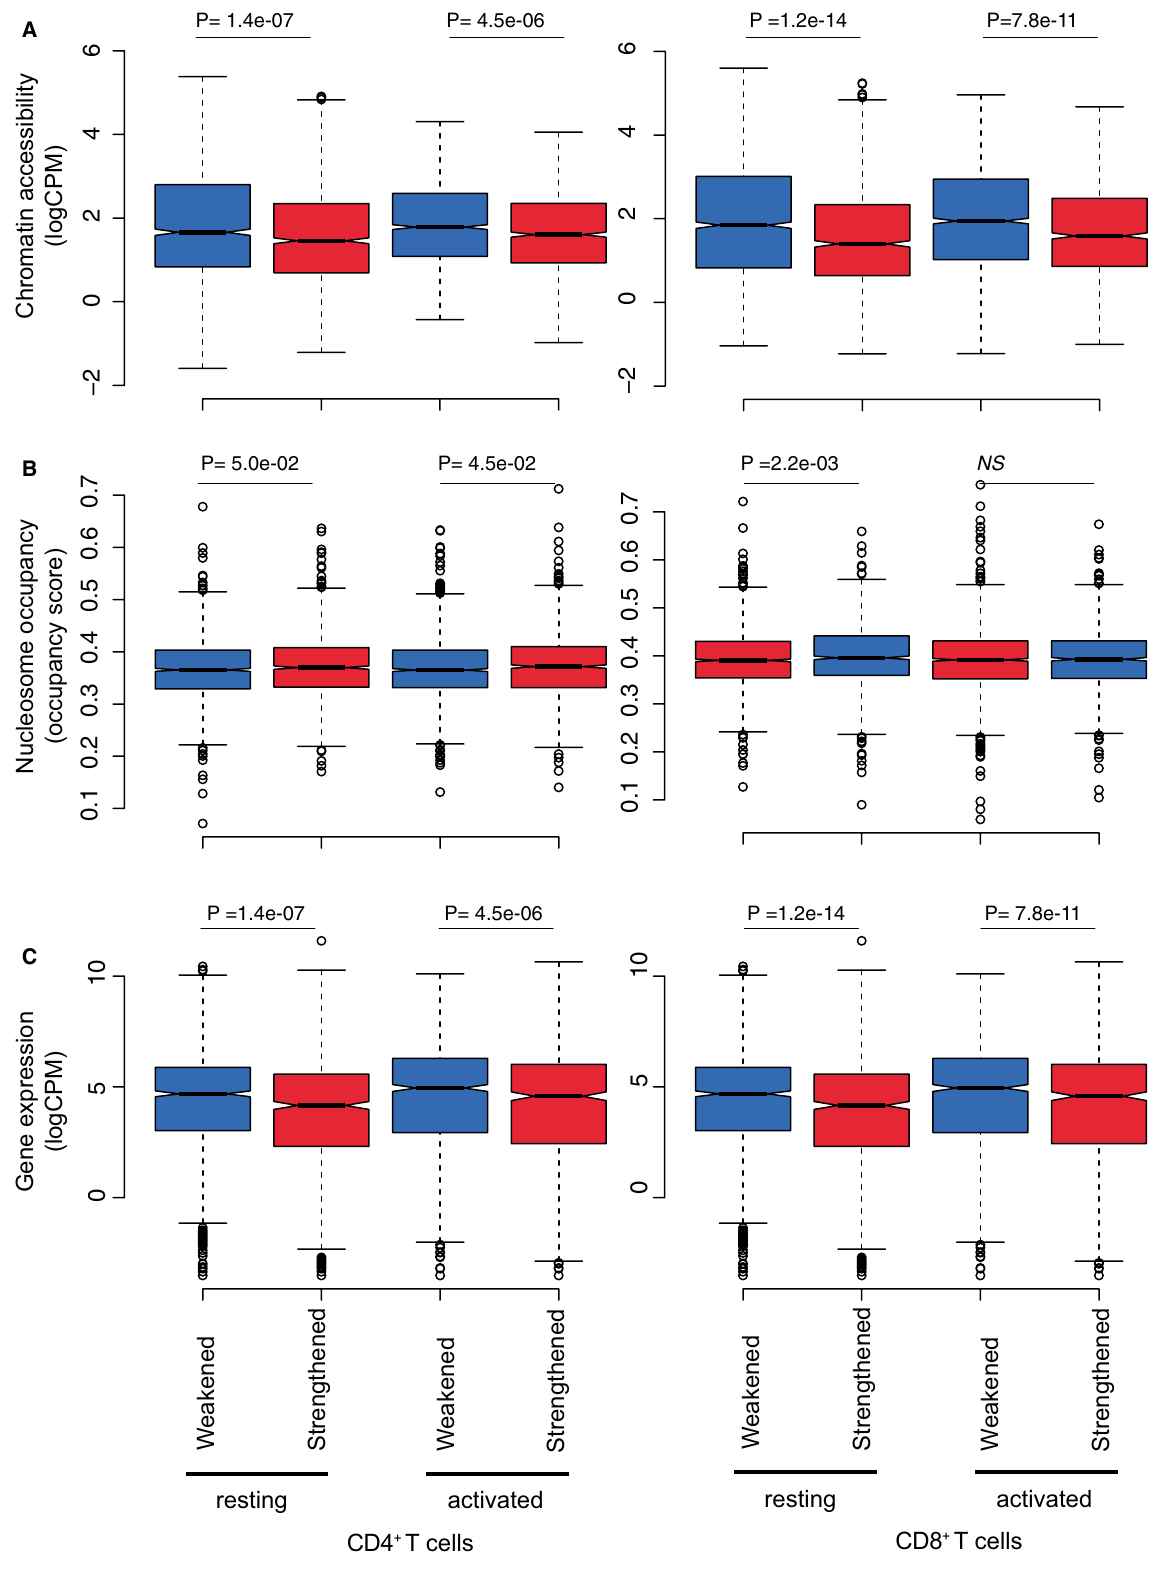
Figure 6. Increased strength in TAD boundary and chromatin interactions upon T cell activation is associated with nucleosome occupancy and gene expression. Box plots showing the distribution of the average ( A ) chromatin accessibility (logCPM), ( B ) nucleosome occupancy (NucleoATAC occupancy score) and ( C ) expression of protein- coding genes (logCPM) across differential TAD boundaries strengthened and weakened following activation of CD4 + and CD8 + T cells. Shown are the median (central horizontal line), interquartile range (boxes), values of the upper and lower quartiles (whiskers), outliers beyond 1.5 IQR (circles). Statistical comparisons were made with unpaired Wilcoxon